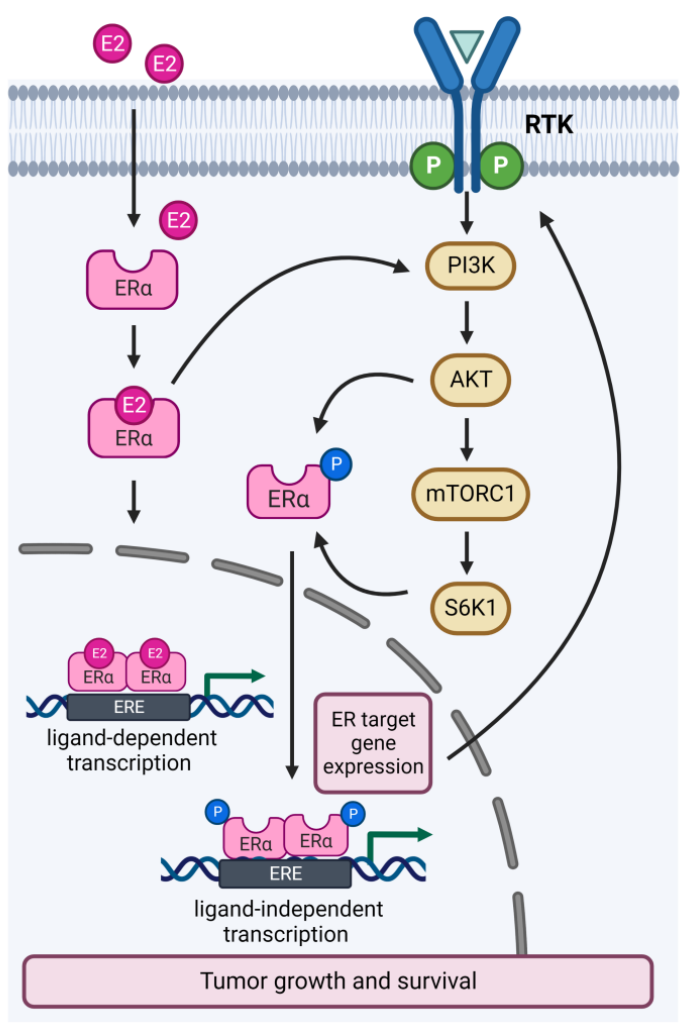
Figure 2. Crosstalk between the PI3K/AKT/mTOR and estrogen receptor pathways in ER+ breast cancer. The ER and PI3K/AKT/mTOR pathways interact directly and indirectly at multiple nodes of each pathway. E2, estrogen; ER, estrogen receptor; ERE, estrogen response elements; RTK, receptor tyrosine kinase.